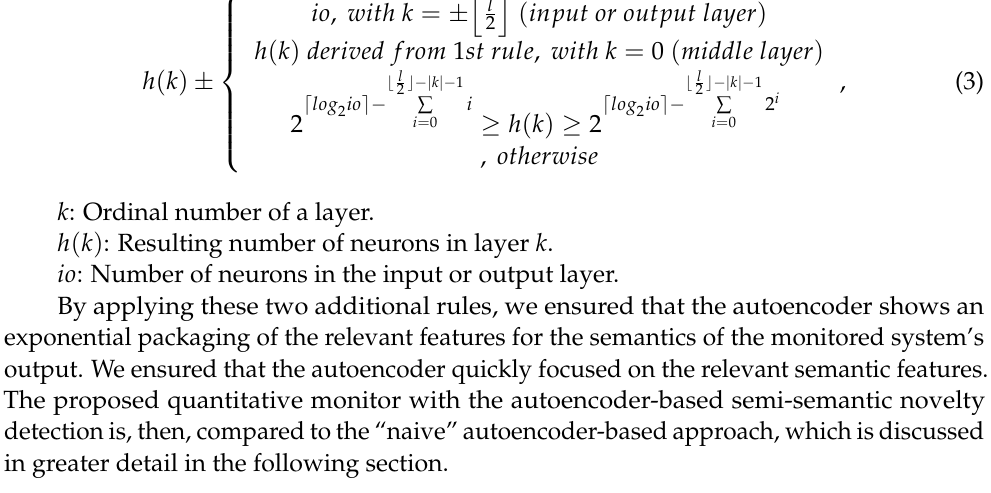
Figure 10. Applying the rules: novelty detection with a semantic topology. 8. Autoencoder-Based Fully Semantic Novelty Detection 8.1. Architecture According to the evaluation results in Section 7, the semi-semantic approach with semantic topology of the autoencoder has shown great performance for minimizing the false negative errors in novelty detection. During the evaluation, we found that the cur- rent classification criterion of the threshold based on MSE could not segment known and novel input data, which were similarly structured but had different semantic meanings, for example, in the case of known digits versus unknown digits (cf. Figure 10). This could also be another reason for the false negative errors in addition to the topology of the au- toencoder. Since the current classification criterion for novelty detection is the threshold solely based on the reconstruction MSE of raw input data, it means that in the case of camera image data, the threshold is determined based on pixel-wise deviations between the raw and reconstructed image without any semantic meaning. In this case, the false negative errors due to similarly structured but semantically different novel data are obviously re- maining. With this hindsight, we propose our next improvement: autoencoder-based fully se- mantic novelty detection based on a semantic error instead of the threshold based on MSE. The architecture of the quantitative monitor using this approach is shown in Figure 11.